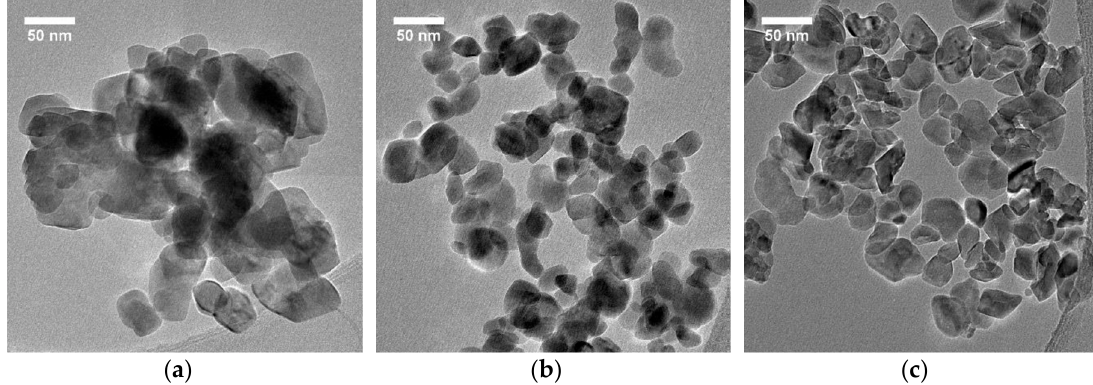
Figure 3. TEM images of LiNbO 3 nanocrystals showing the influence of the glycol chain length for a molar ratio of glycol to ethanol at r = 0.5. For a precursor volume fixed at 5 mL, we added ( a ) 3.1 mL of 1,3-propanediol, ( b ) 3.8 mL of 1,4-butanediol, and ( c ) 4.5 mL of 1,5-pentanediol.